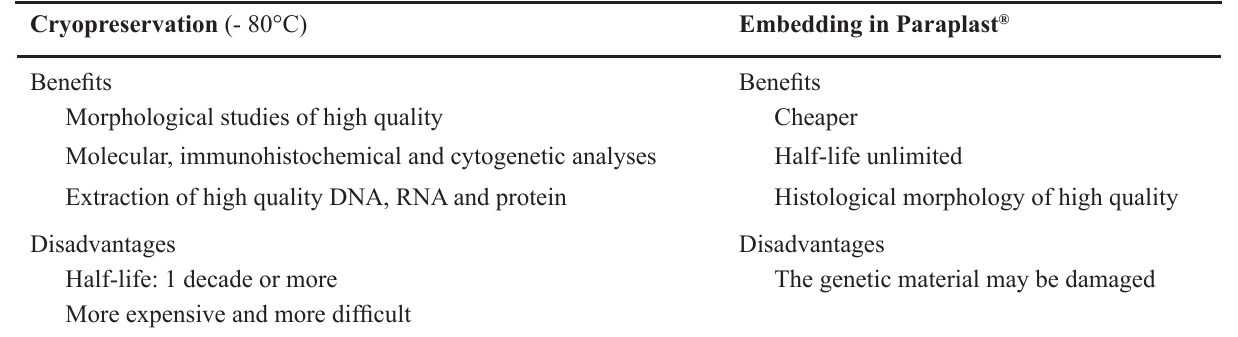
Table 1 – Procedure for storage of collected